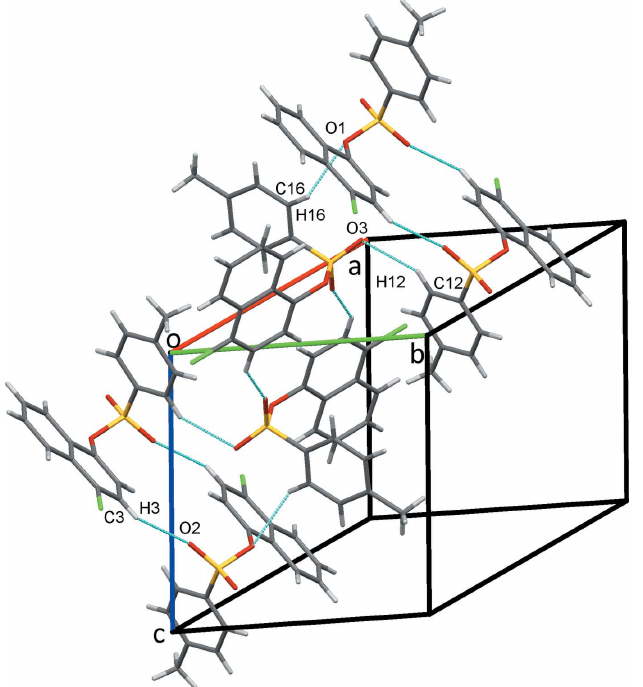
Figure 3 Overall packing viewed along the b -axis direction. Representative